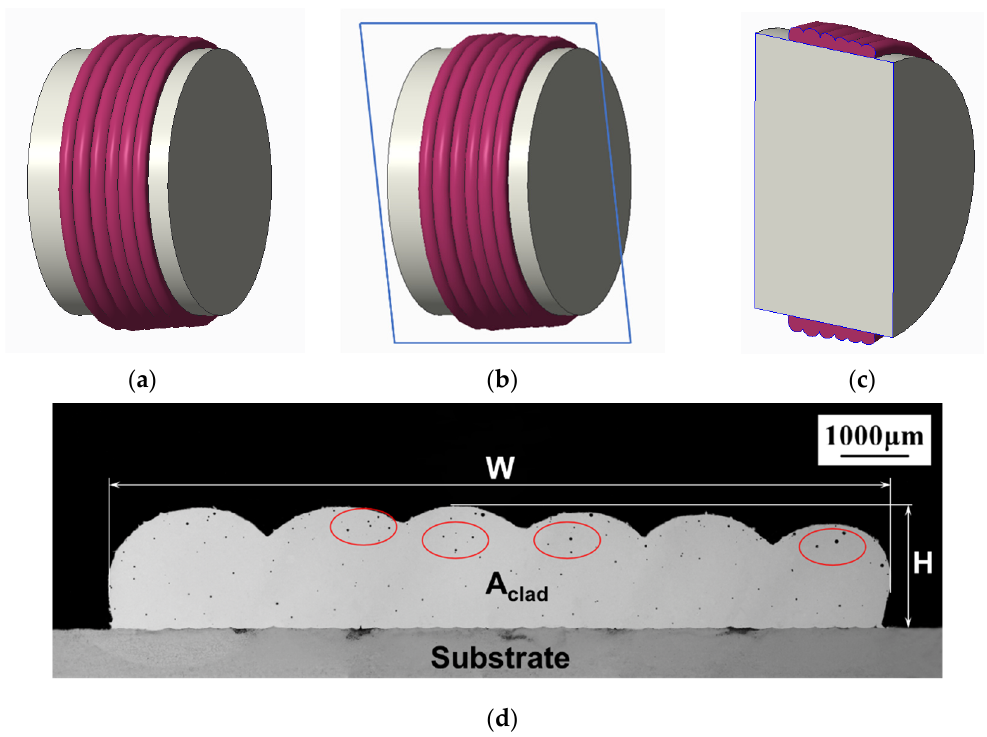
Figure 2. ( a ) Schematic illustration of laser cladding tracks on a round rod; ( b ) schematic illustration of a linear cutting location to obtain the cross-section of the cladding layer; ( c ) schematic illustration of the cladding layer’s cross-section to be investigated; ( d ) example microstructure in the cross-section of the clad coated on the substrate .